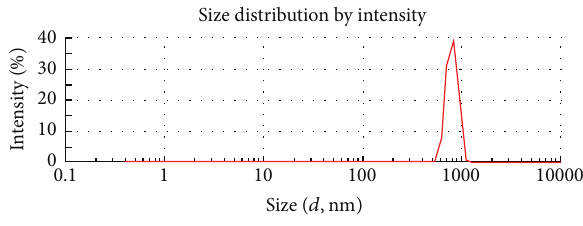
Figure 3: DLS size distribution of ASF